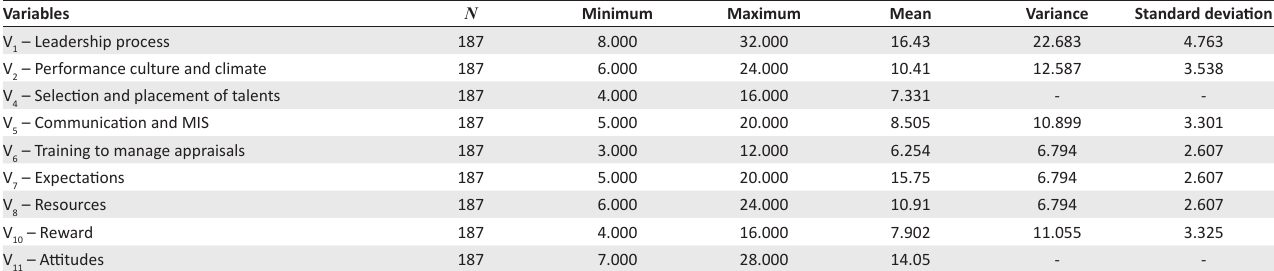
TABLE 5: Descriptive statistics of determinants of the EPMDS effectiveness.